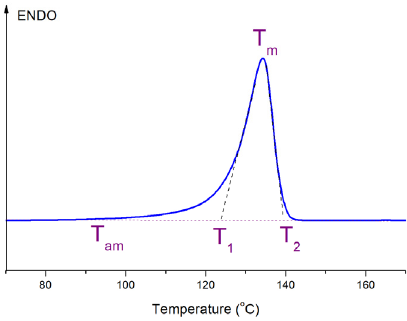
Figure 3. An example of the melting thermogram of the pure HDPE undrawn